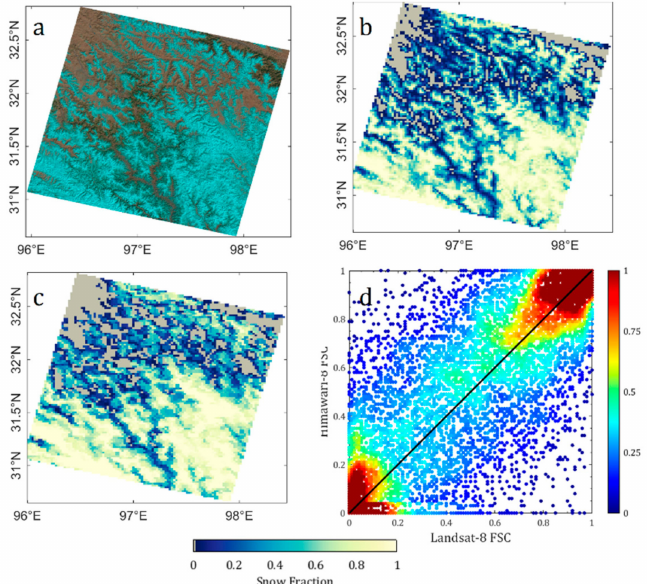
Figure 10. A case evaluation of Himawari–8 AHI fractional snow cover with Landsat–8 data for vegetated land: ( a ) Landsat–8 OLI image at WRS 134 / 038 on 27 February 2016; ( b ) the corresponding Landsat–8 fractional snow cover; ( c ) the corresponding Himawari–8 AHI fractional snow cover at UTC 4:00 a.m.; ( d ) the scatter plot displaying 10,394 points of Himawari–8 AHI fractional snow cover versus Landsat–8 fractional snow cover at a 0.02 ◦